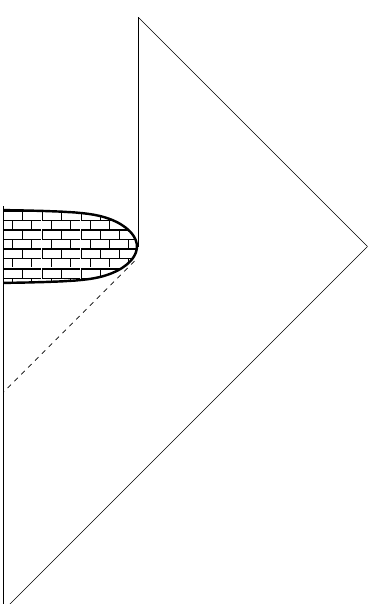
Figure 6. The Euclidean region as a final boundary on which future data are posed and not evolved